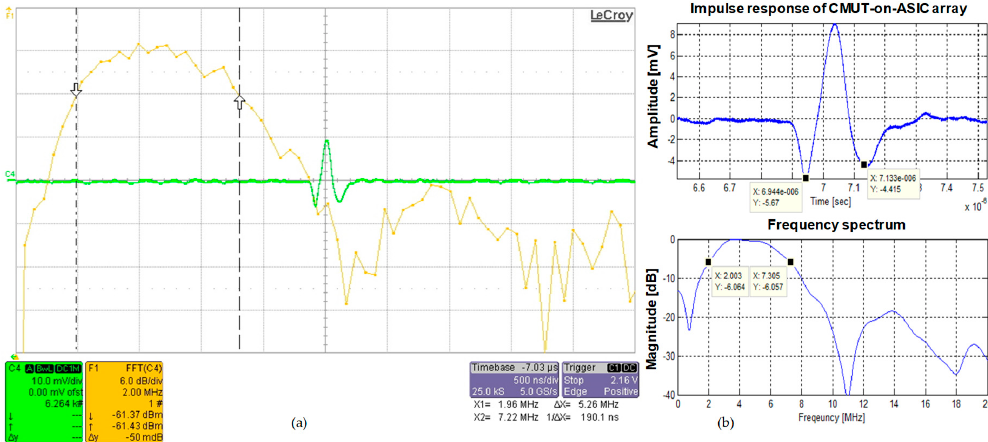
Figure 3. The impulse response (green line in ( a ) and upper figure in ( b )) and the frequency spectrum (yellow line in ( a ) and lower figure in ( b )) of the CMUT-on-ASIC array: ( a ) a picture captured from oscilloscope; ( b ) off-line plot using MATLAB with the impulse response